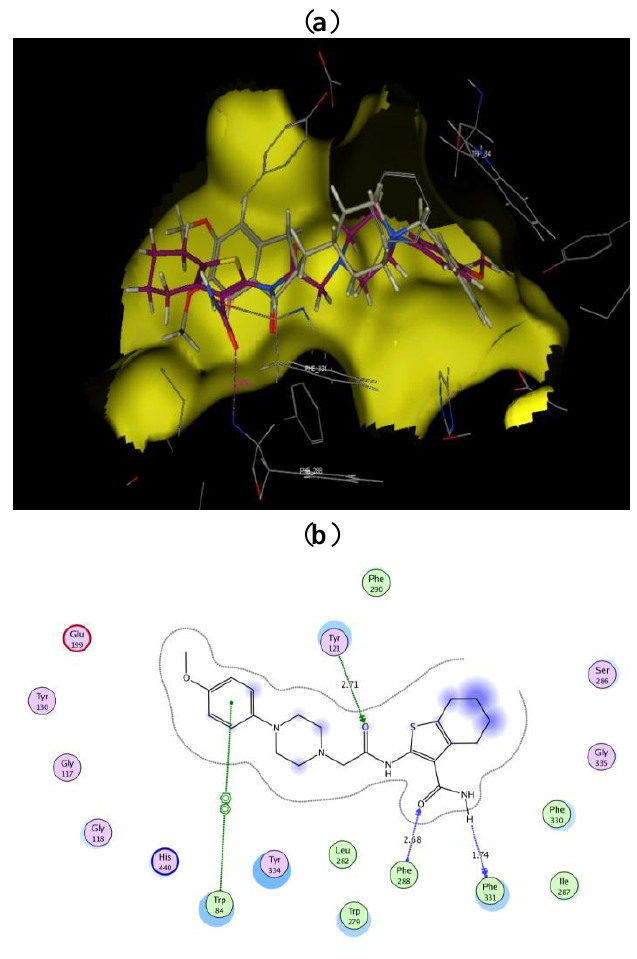
Figure 5. ( a ) Docked conformation alignment of III (red) and its original co-crystallized d ligand (grey) in the AChE binding site generated by MOE docking. ( b ) simplified structure showing interaction between III and the aromatic residues in the AChE active d